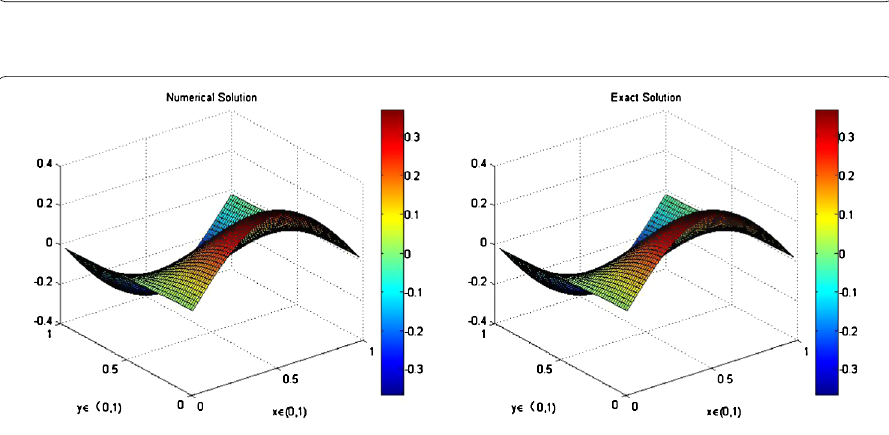
Figure 11 The effect of numerical solution and exact solution at fixed T = 1, h = 1 Example 3. ( a ) N = 2 6 . ( b ) N = 2 6